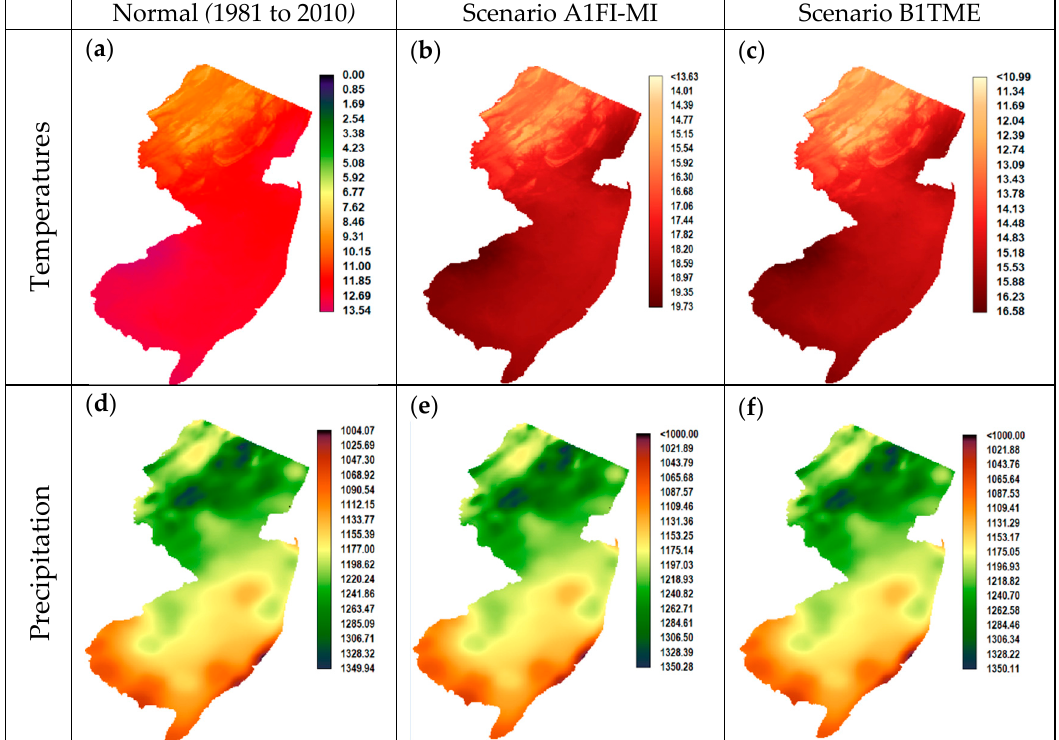
Figure 3. State of New Jersey: Downscaled mean annual temperatures ( a ) and annual precipitation from 30-year normals (1981 to 2010) ( d ) and projected annual average temperature change in degree Celsius ( b , c ) and annual precipitation change in mm ( e , f ) by 2100 based on scenario A1FI-MI and B1TME respectively. The temperature variation within the state ( a , b , c ) is represented by the red color, the darker the color the hotter the temperature and the lighter the color the cooler the temperature (Refer to the legend to the right for related numerical detail). The precipitation distribution varies from red to green colors ( d , e , f ). More precipitation is represented by dark green while less precipitation is in darker red color (Refer to the legend to the right for numerical association and the amount of precipitation).